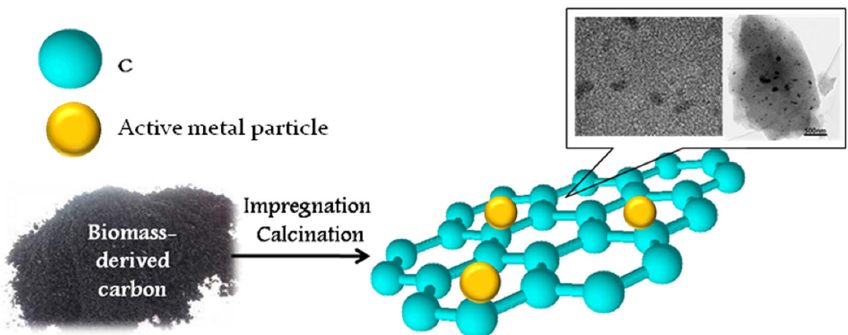
Figure 4. Preparation of biochar ‐ based metal ‐ containing catalysts. Summarized from [57,58].